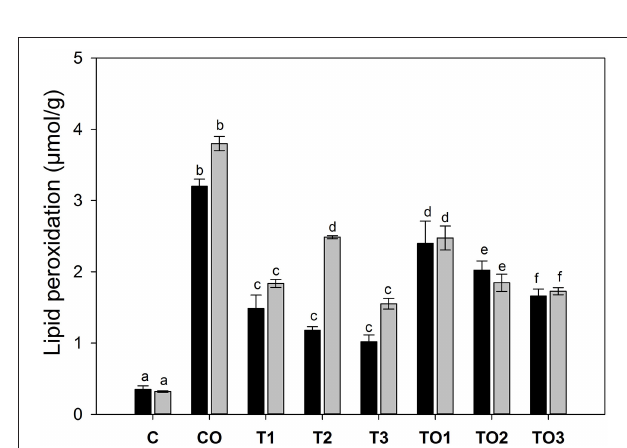
FIGURE 3 | Effects of supplementation of α -tocopherol alone or in combination with oxidized olive oil on the amount of polar compounds. Different letter (a–f) in the male or female rats represents significance at p < 0.05 ( n = 3). M, F, T, C, and O are the abbreviations for male, female, tocopherol, control and oxidized lipids. Statistical comparison was carried out within the same male and female group independently. Black bars are male groups, while gray bars are female groups.